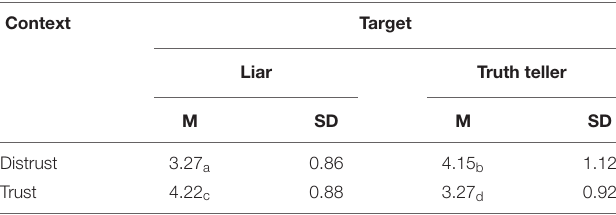
TABLE 1 | Means and standard deviations of participants’ judgments of the targets’ deception, as a function of context and target for Study 1 (the higher